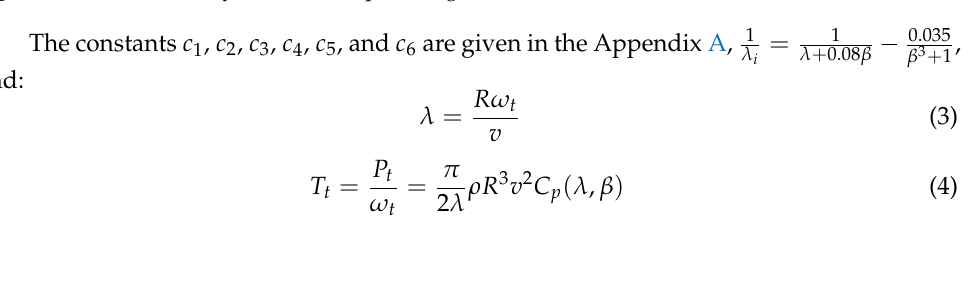
Figure 3. Power efficiency for different pitch angles and TSR.